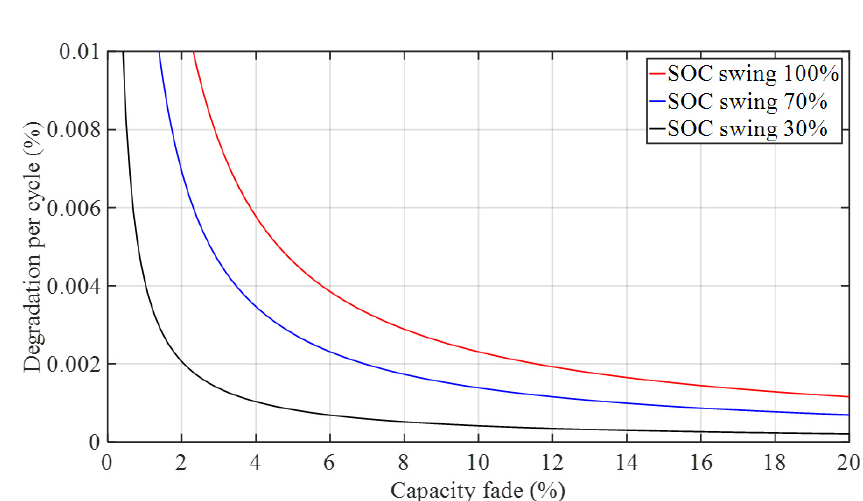
Figure 8. Model of cycle lifespan degradation according to capacity Figure 8.safjpj ‘jopaj jo[iop